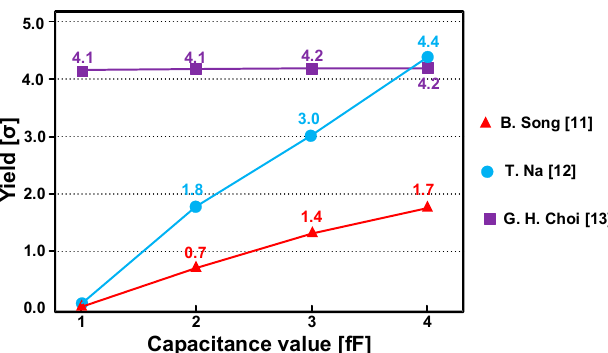
Figure 4. Restore yield of three state-of-the-arts NVFFs [11–13] having the offset-tolerant characteristic relative to the capacitance (C SA or C EQ ) value at SS corner (NMOS = Slow, PMOS = Slow). For this simulation, V DD of 0.6 V is used.